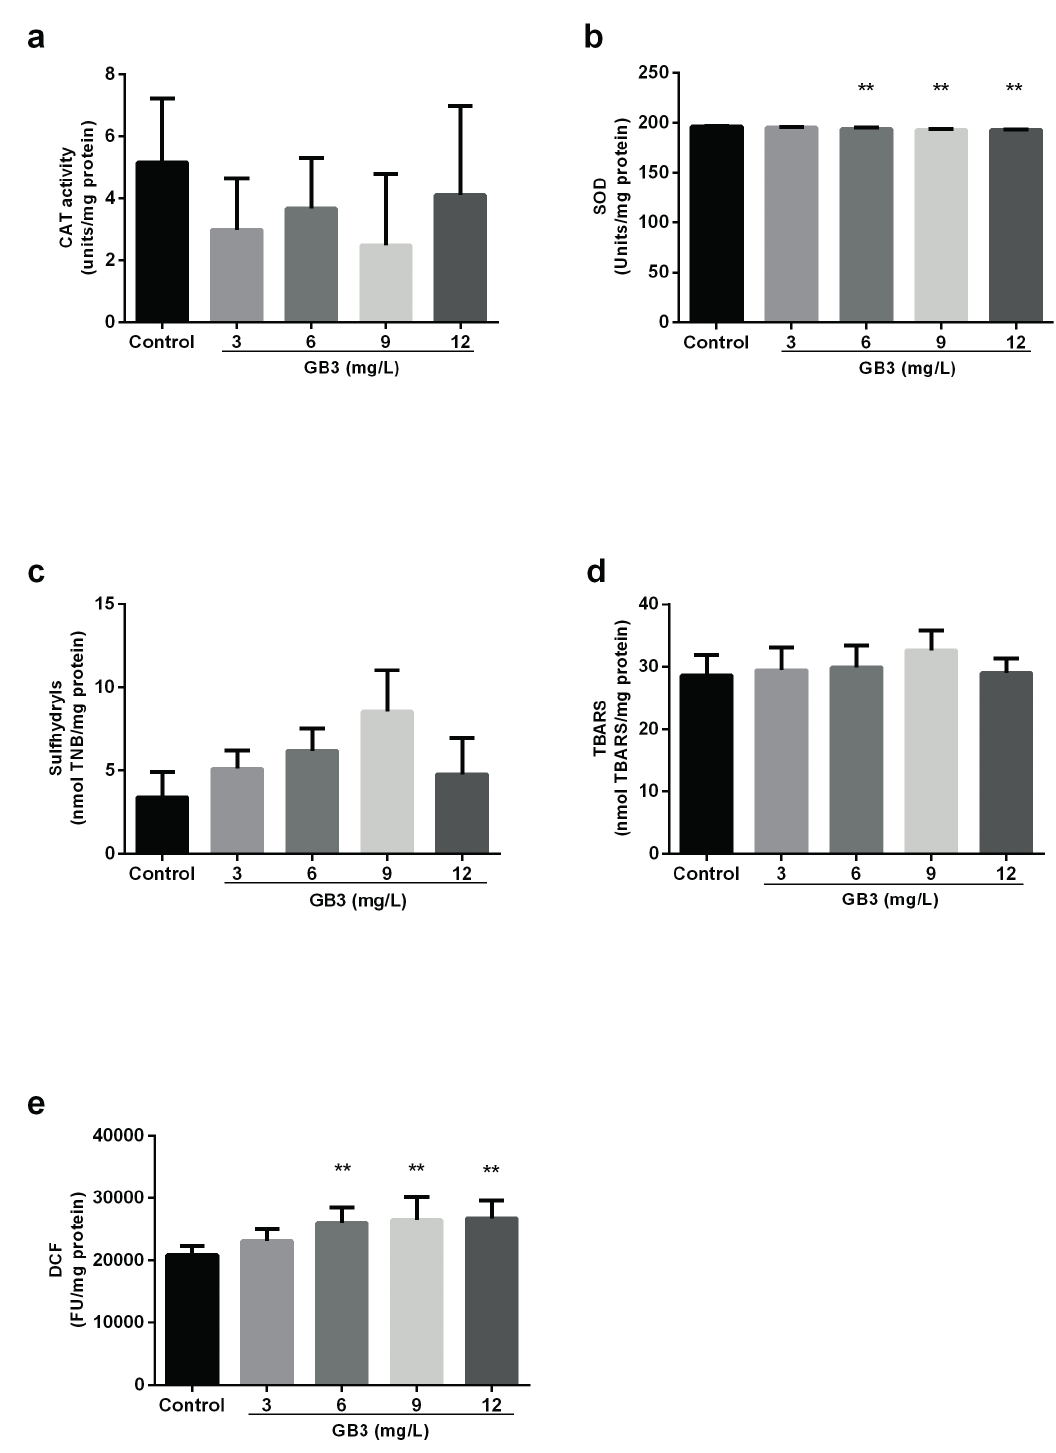
Figure 1 - In vitro effect of GB3 on catalase (CAT) activity ( a ), Superoxido dismutase (SOD) activity ( b ), sulfhydryl assay ( c ), lipoperoxidation ( d ) and production of reactive species ( e ) in cerebral cortex of Wistar rats. Values are means ± S.D. (n=6). Statistically significant differences from controls were determined by ANOVA followed by Tukey test: ** p <